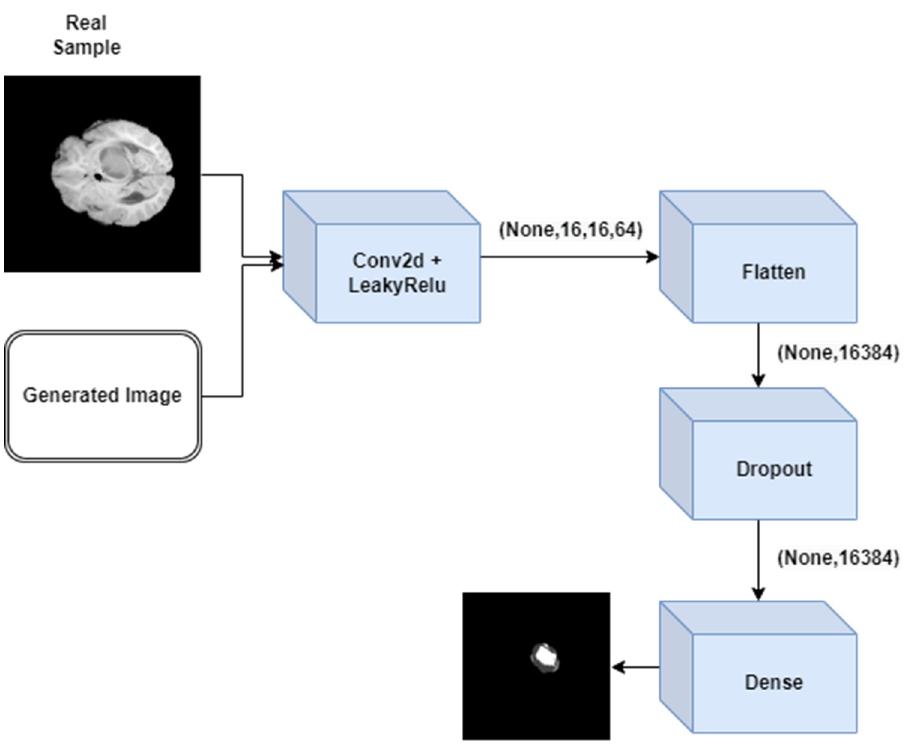
Figure 3. Architecture of discriminator GAN.